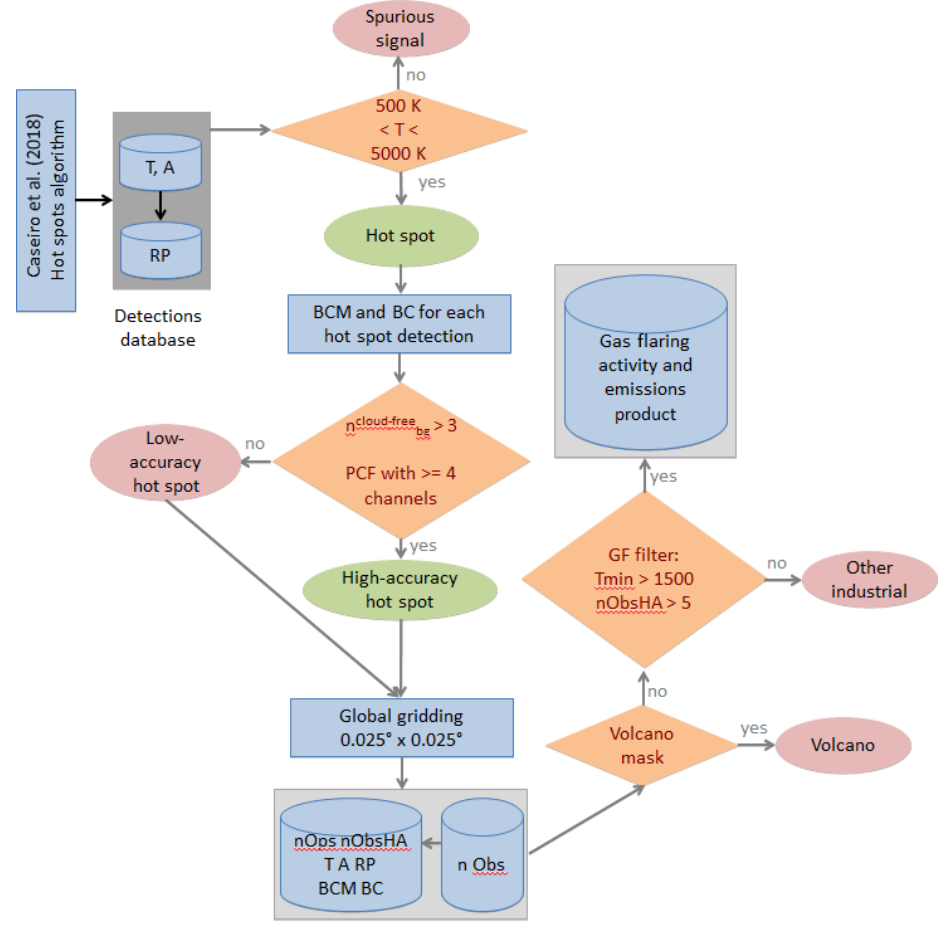
Figure 1. Flowchart of the methodology used in the present work. The starting point is the hot spot algorithm detection described in Caseiro et al. (2018) which, after applying a filter on the retrieved temperature (500K < T < 5000K), produces a database of valid hot spot detections. For each of these valid hot spot detections, the activity (billion cubic metres, BCM) and black carbon (BC) emissions are computed. The valid hot spot detections are further filtered: detection in at least another band besides S5 (S6 or S7 or F1, meaning that with the LWIR there are at least 4 points for the Planck curve fit, PCF) and at least 3 cloud-free pixels in the background to compute the background radiances. This step produces a database of high-accuracy hot spot detections. All hot spot detections are gridded into a global 0 . 025 ◦ × 0 . 025 ◦ grid. For each grid cell, the following quantities are computed: the number of valid detections ( n Obs ), high-accuracy detections ( n ObsHA ), days of operation ( n Ops ) (see below, Sect. 2.2.2), temperature, area, radiative power (minimum, average, maximum, and standard deviation), the date of the first and the last detection, and the sum of the activity (BCM) and BC emissions. A volcano filter is applied to the global grid in order to mask out volcanic activity (see Sect. 2.2.1). The last step is the discrimination of grid cells for flaring activity (see Sect. 2.2.2).